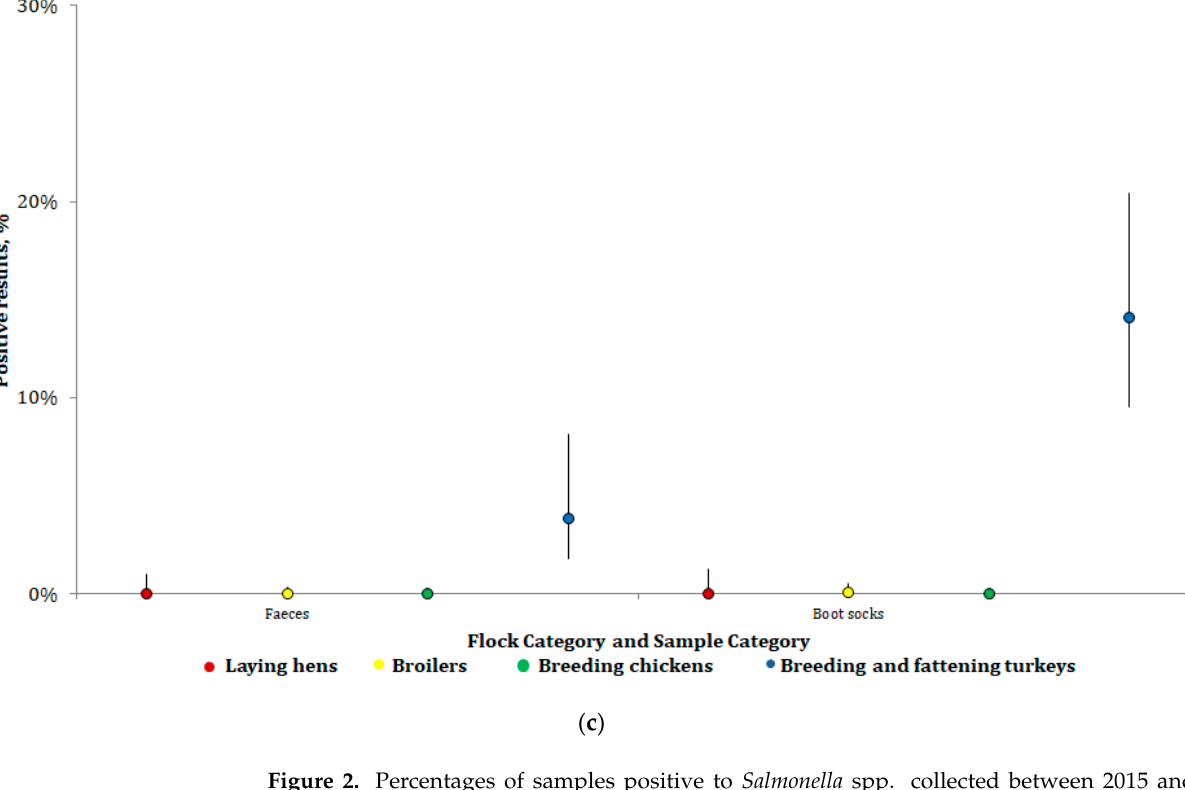
Figure 2. Percentages of samples positive to Salmonella spp. collected between 2015 and 2020 in Abruzzo and Molise Regions and related C. I. ( a ) Percentages of positive samples per flock category; ( b ) Percentages of positive samples per sampling method; ( c ) Percentages of positive samples according to sampling method and flock categories. Table 3. Percentages of samples positive to Salmonella spp. collected between 2015 and 2020 in Abruzzo and Molise Regionsby flock category.